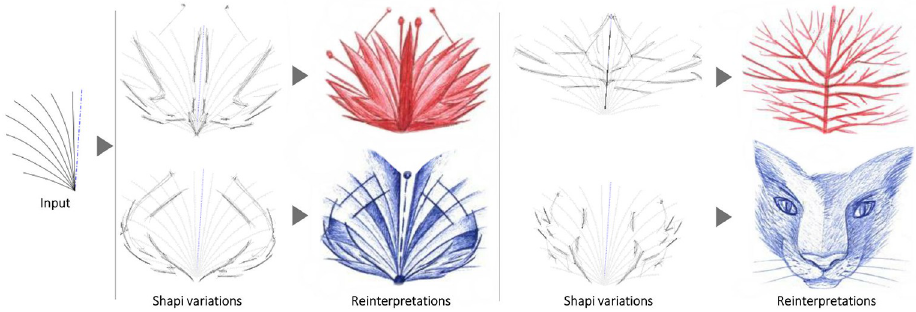
Fig 17. Some implementations with artistic open-ended purposes. The Seeds of three objects (hand-axe, lamp shade, and bottle) are used to reinterpret and discover new entities (human sketches on the right).